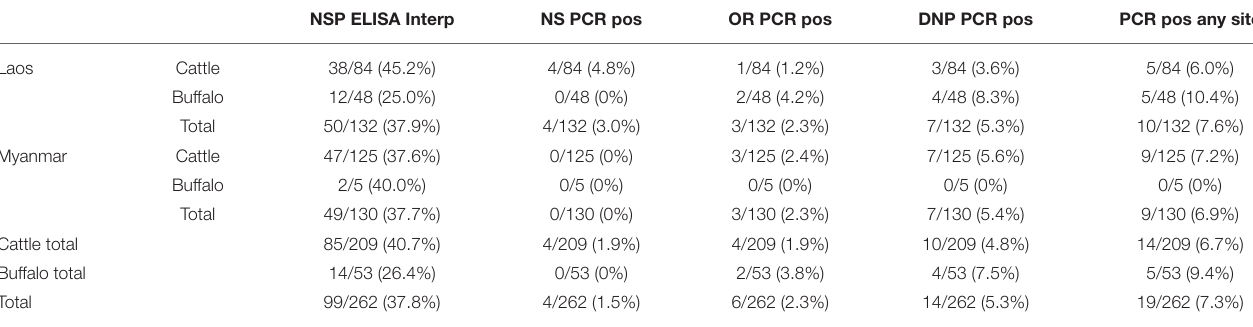
TABLE 1 | PCR and NSP ELISA results from healthy cattle and buffalo ( n = 262) tested at slaughter in Laos (Dongdou and Nongduang) and Myanmar